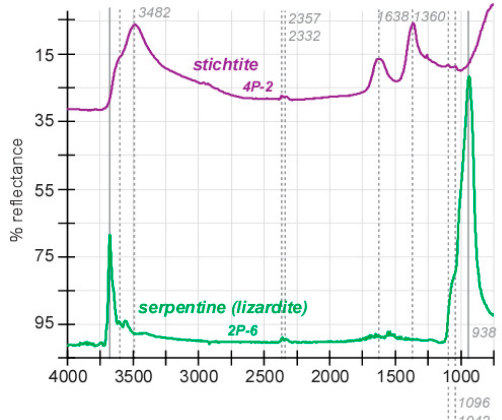
Figure 3. Plot of Fourier transform infrared spectroscopy (FTIR) spectra of stichtite (purple line) and its serpentine (lizardite) mineral host (green line). The peak positions in wavenumbers (cm − 1 ) for stichtite key features are marked with dashed vertical lines. Peak positions in wavenumbers (cm − 1 ) for key features in serpentine are marked with vertical solid lines. Peaks between 3700 and 3482 cm − 1 correspond to OH − stretching modes. The 1638 cm − 1 peak is a deformation mode of molecular H 2 O. The 1360 cm − 1 peak is a CO 32 − antisymmetric stretching mode. The 938 cm − 1 peak corresponds to Si–O vibrations in the SiO 42 − tetrahedron.